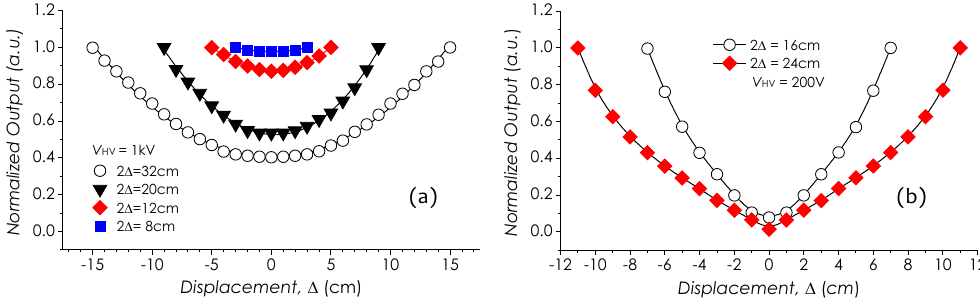
Figure 18. Field distributions between electrodes, measured with ( a ) our sensor and ( b )